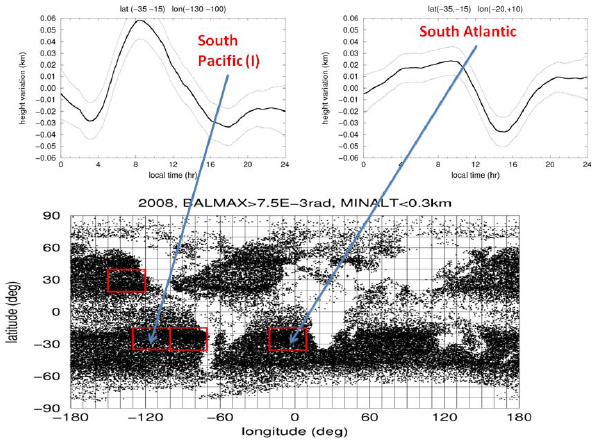
Fig. 24. Variability of the ABL depth over the oceans and some land areas in 2008 from COSMIC data (Sokolovskiy et al., 2010).